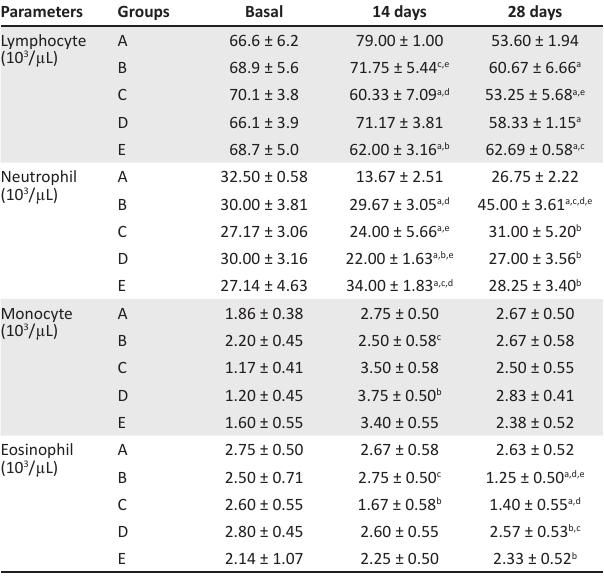
TABLE 4: Effects of Vernonia amygdalina on mean corpuscular volume, mean corpuscular haemoglobin and mean corpuscular haemoglobin concentration of alloxan-induced diabetic rats.